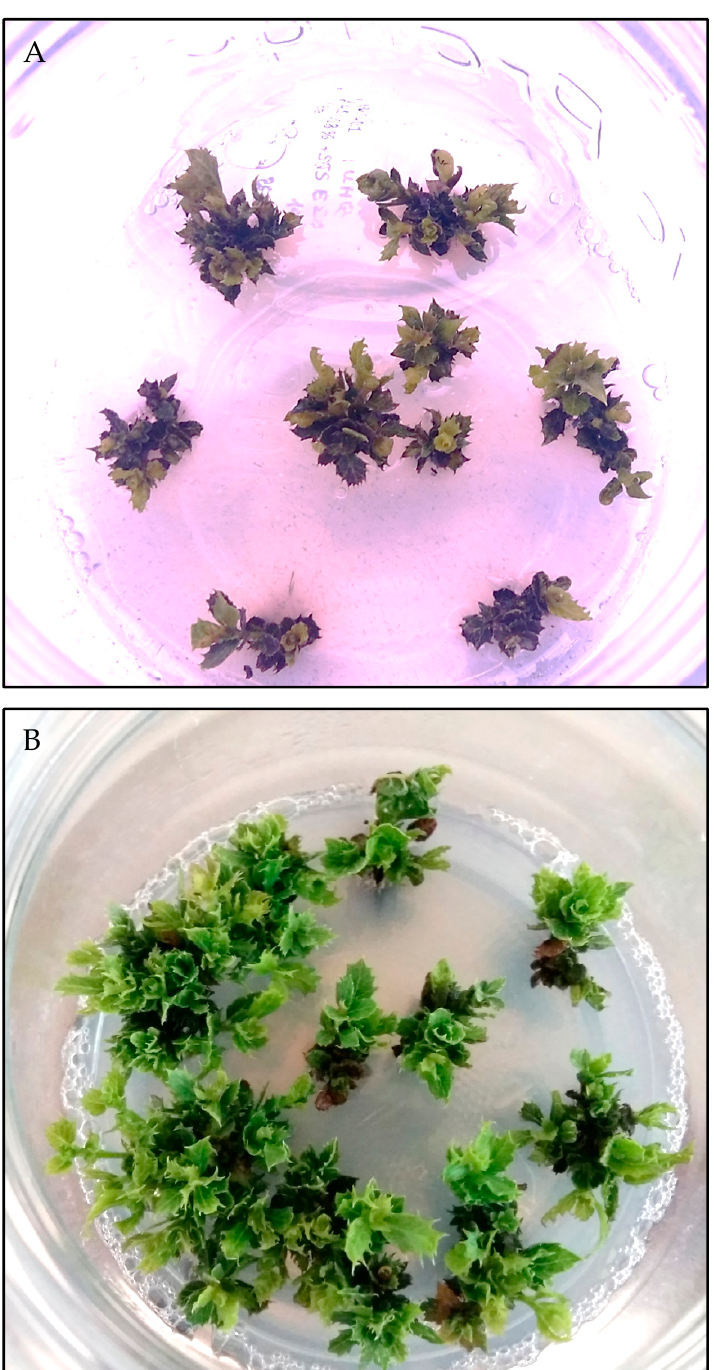
Figure 2. Cold storage of shoot cultures from holm oak tolerant plants. ( A ) Shoot explants after nine months of cold storage on proliferation medium under dim lighting. ( B ) Shoot recovery after nine months of cold storage, and regrowth after four weeks in culture under standard conditions.